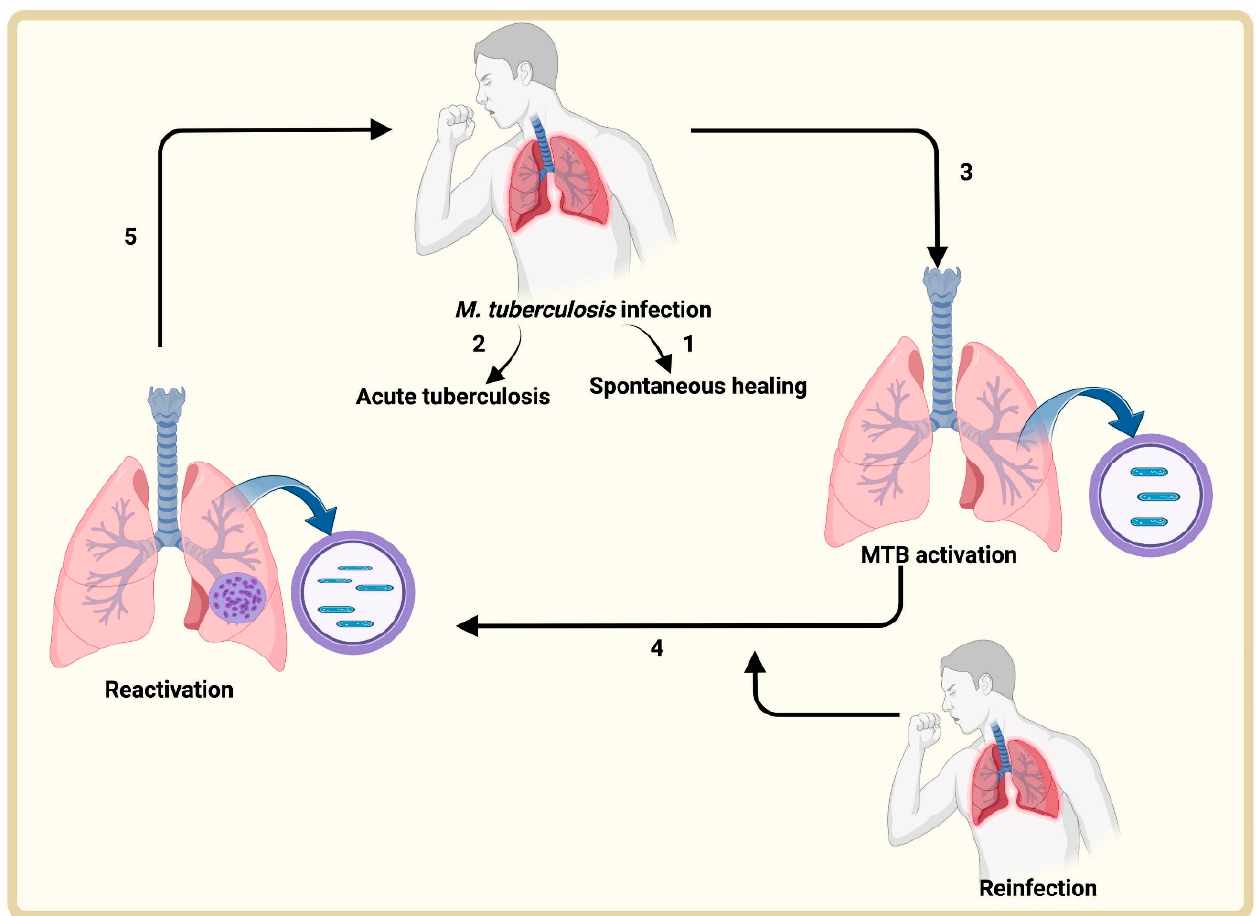
Figure 1. Tuberculosis infection cycle. Air-borne aerosols encapsulating MTB are inhaled by patients. These microorganisms face different outcomes: (1) the pulmonary immune system eliminates MTB; (2) it leads to active TB; (3) the infection progresses to latent TB; (4) the latent TB is reactivated by an endogenous or exogenous means or both; (5) active MTB infection, progression and transmission.